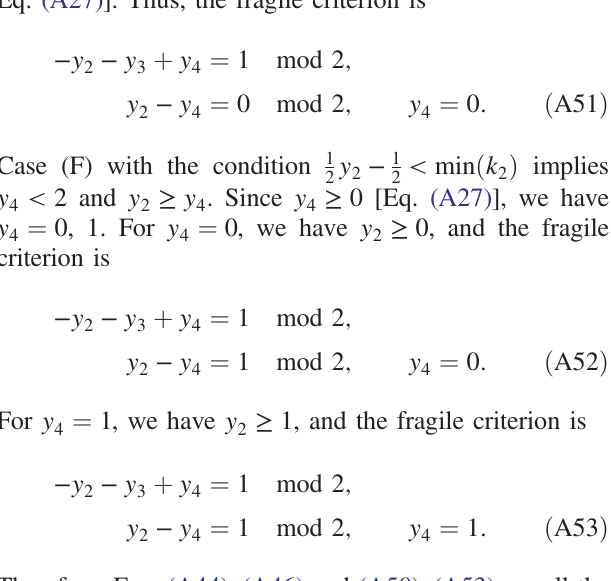
− y 0 plane; (d) the y 1 3 ¼